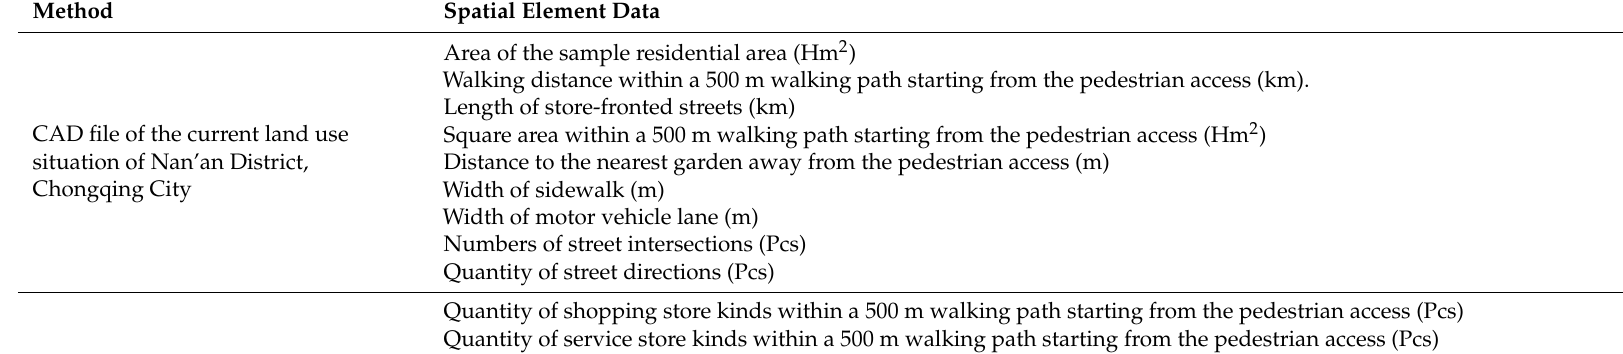
Table A3. List of spatial element data collected with each